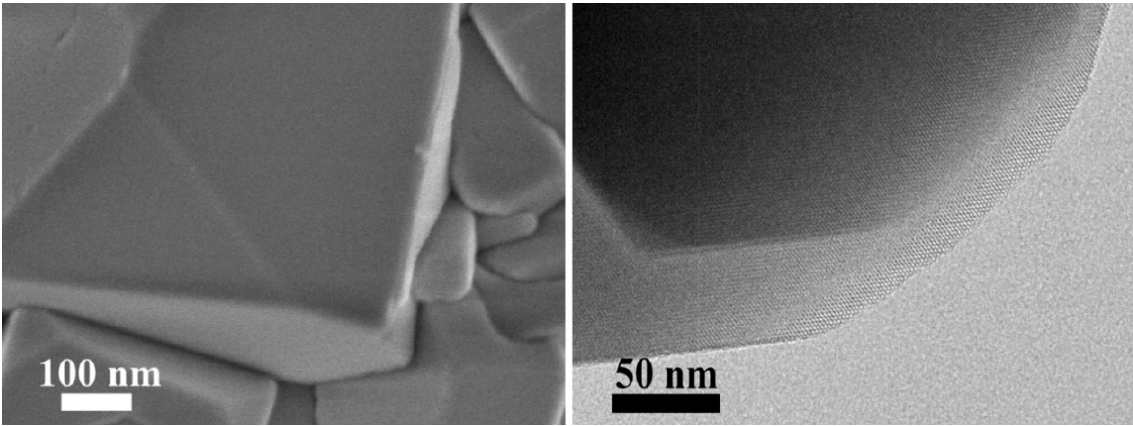
Figure 3. FESEM and HR-TEM micrographs of pristine ZSM-5 zeolite.